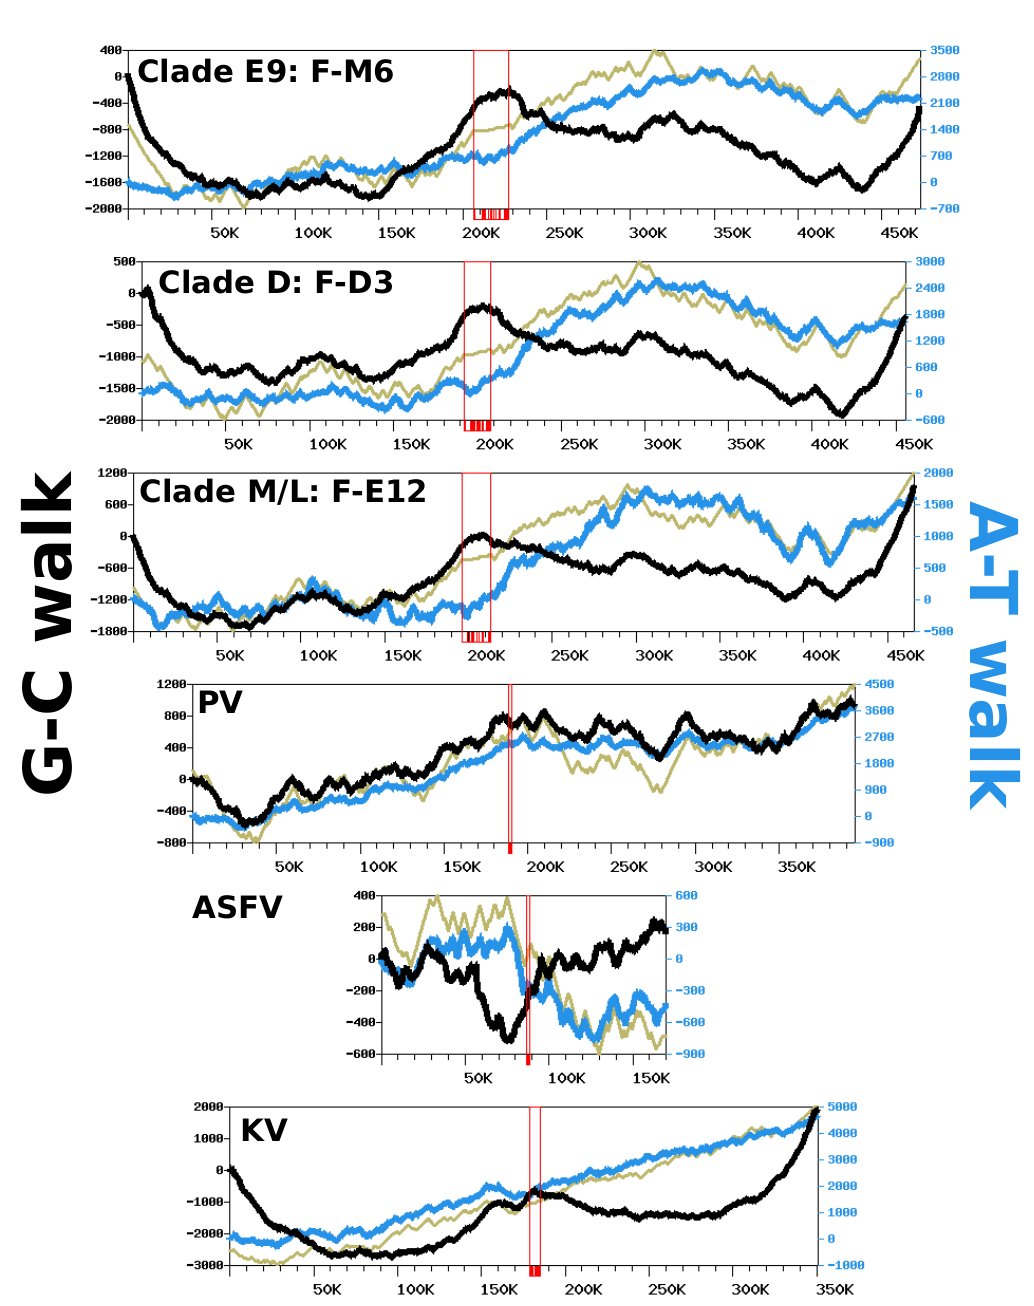
Figure 5. Complimentary nucleotide composition bias along viral genomes. Each graph represents the G-C walk (black), A-T walk (blue) and CDS walk (kaki – y-axis not shown). Open red rectangles indicate the position of the MCP genes, with individual exons shown with shaded boxes below the x-axis. The x-axis units are base pairs. PV: Pacmanvirus A19; ASFV: Asfarvirus BA71V; KV: Kaumoebavirus Sc. The same compositional analysis was performed for viruses closely related to FVs, including—by increasing phylogenetic distance—Pacmanvirus (PV), ASFV and Kaumoebavirus (KV). The amplitudes of the respective curves were comparable to those of the FV genomes, except for the KV curves, which were always greater. For both the G-C walk and the A-T walk analysis, the curve shapes were considerably dissimilar between viruses, with the exception of KV for which the G-C walk produced a W-shape similar to the corresponding curves in FVs, with three maxima co-locating on the chromosome extremities and the MCP